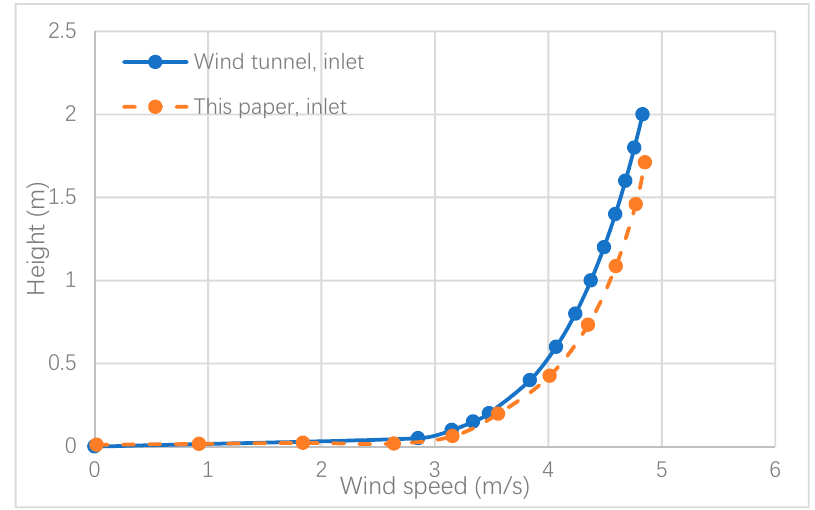
Figure 8. Validation of wind velocity profile.